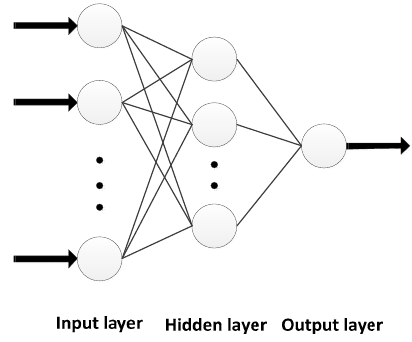
Figure 2. The structure of the neural network.